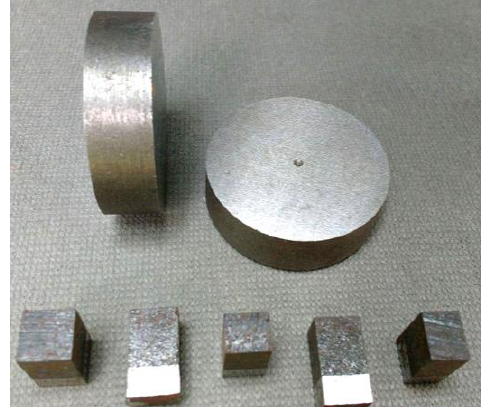
Fig. 2. Friction pads 14 × 14 × 20 mm (cut from brake pads) and gray cast iron blanks (ø70 × 15 mm discs) for the manufacture of brake discs